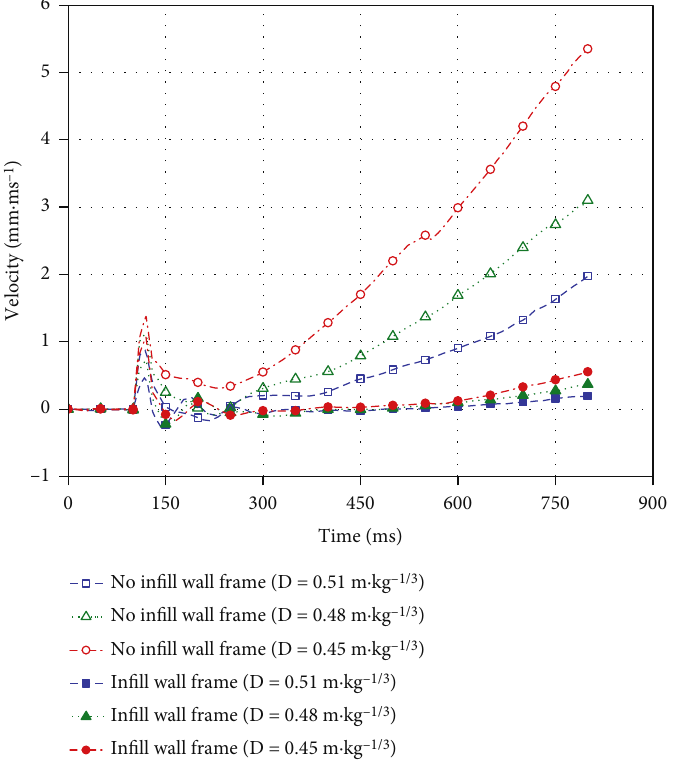
Figure 9: The Y -direction velocity of the apex of the bottom